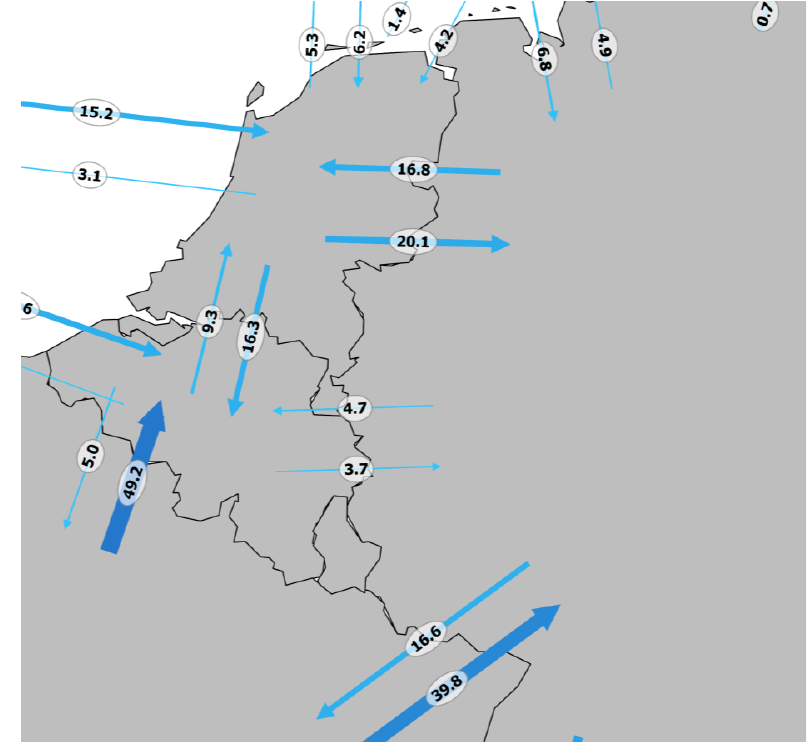
Figure 11. Aggregated commercial flows in TWh.